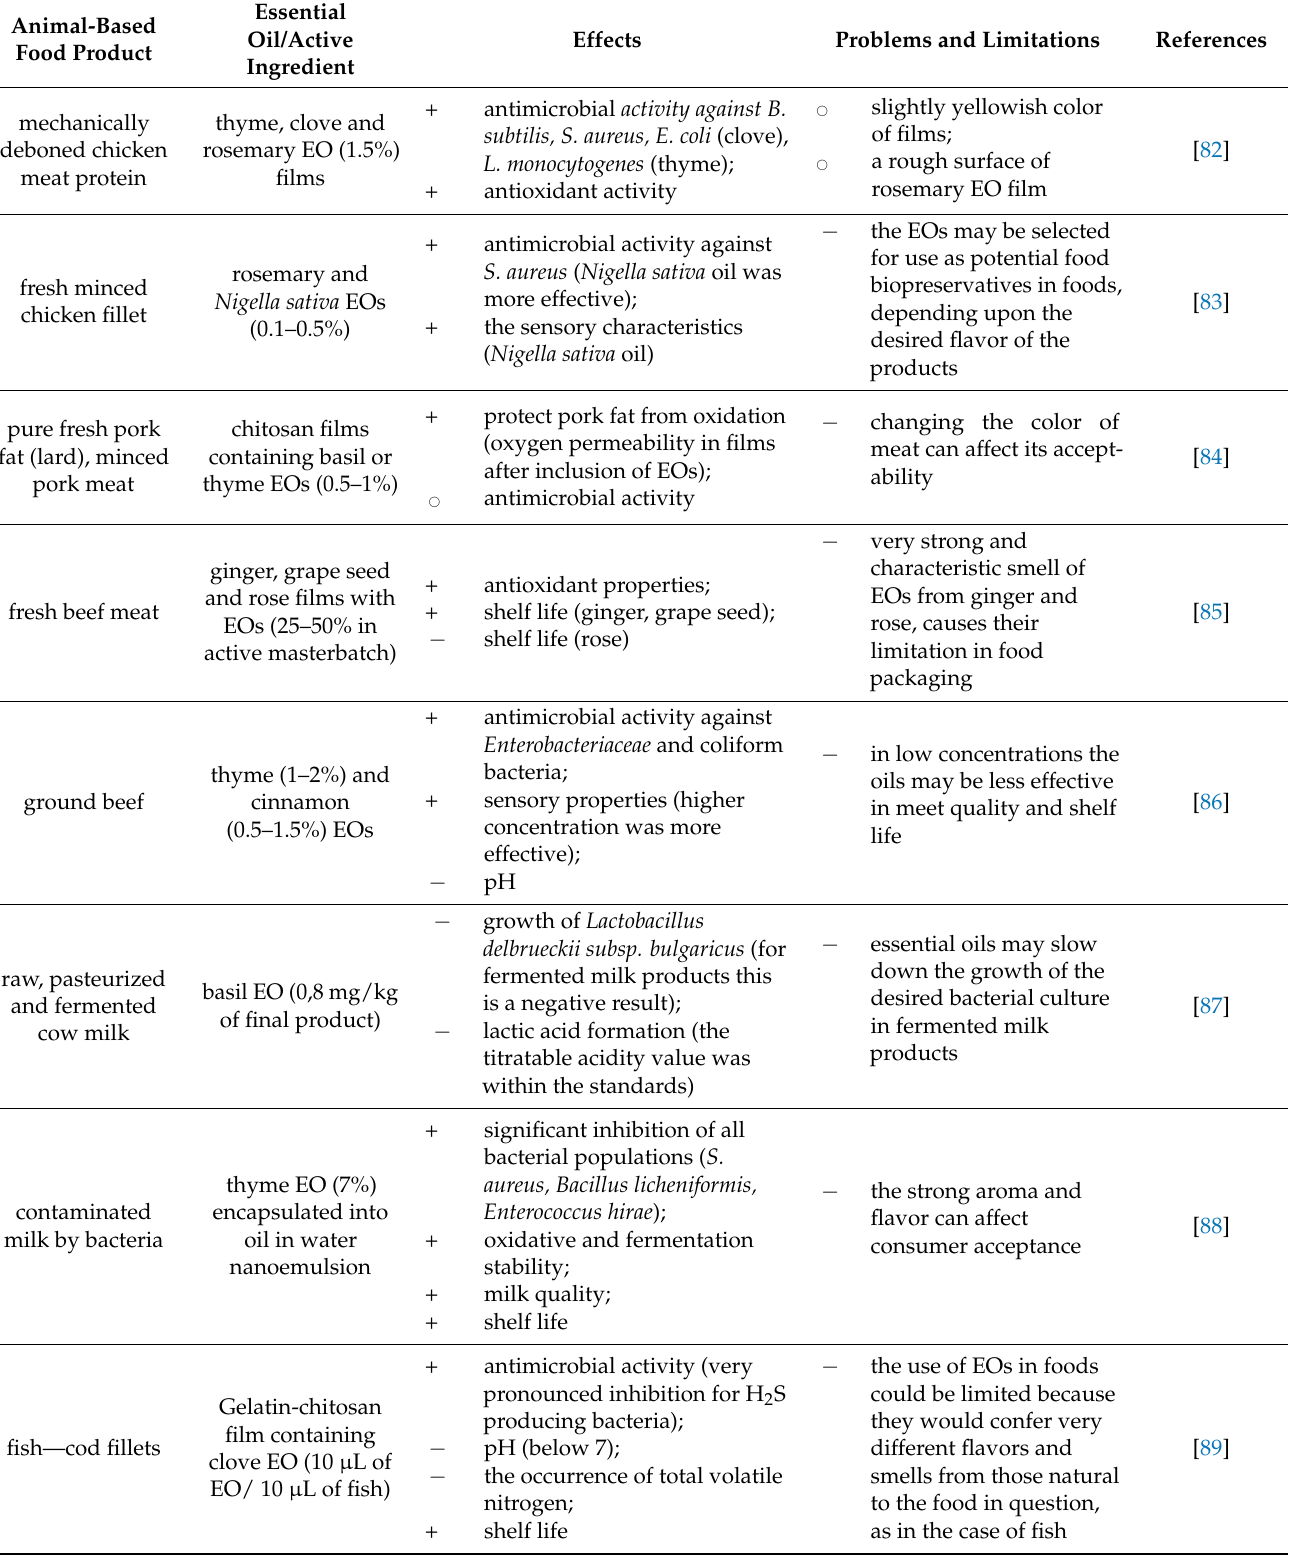
Table 5. The effect of essential oils (EOs) and their active ingredients on the animal-based food products.